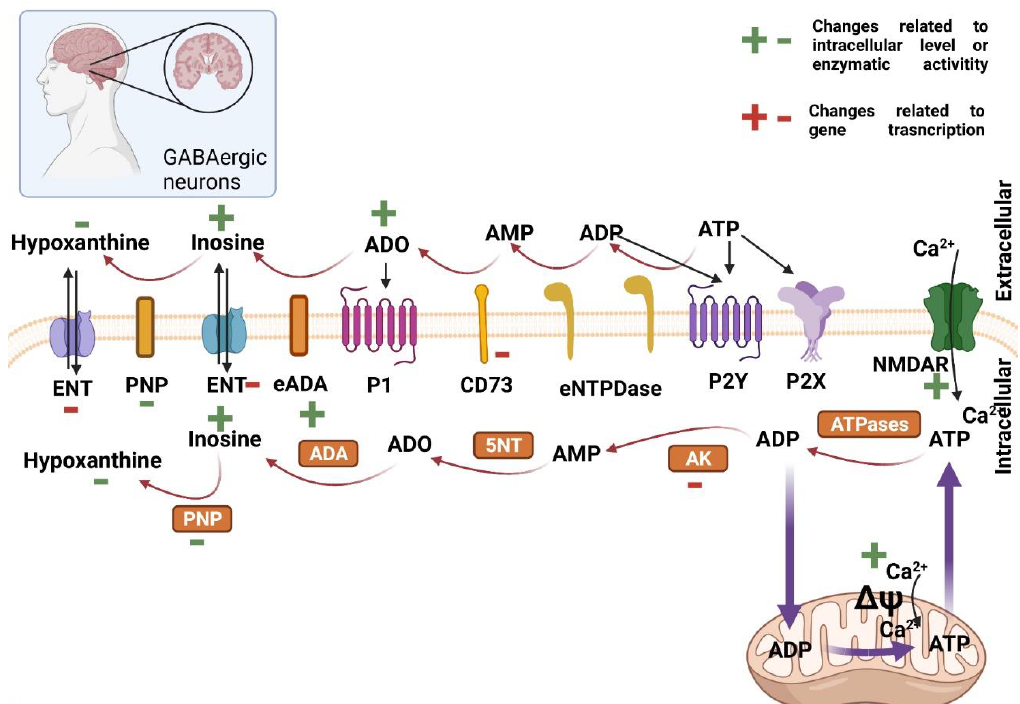
Figure 1. Purine metabolism and signaling in healthy and Huntington’s disease striatal GABAergic neurons. In the neurons of the striatum, ATP is heavily produced by mitochondria which also play important role in buffering cytosolic calcium signaling. In the cytosol, many enzymes (orange boxes) can convert ATP to AMP, ADO, IMP, inosine, and hypoxanthine. The latter ones can be transported to the extracellular milieu by ENT. Extracellularly, ATP can also be converted to inosine and hypoxanthine through a similar cascade by extracellular-faced enzymes anchored to the cell membrane. CD73 is the only extracellular 5NT. Pathophysiology of Huntington’s disease exerts alterations in the activity of enzymes (marked in green +/-) or by genomic expression (marked in red +/-). In Huntington’s disease condition, NMDA-glutamate receptors permit uncontrolled Ca 2+ influx into cells. The excessive Ca 2+ is transported to mitochondria, where it disrupts the membrane potential, releasing cytochrome c and promoting cell death. P1 —Adenosine receptor; P2X —ATP receptor channel; P2Y —ATP/UTP receptor; ATPases —adenosine-5′-triphosphatases; AK —adenylate kinase; eNTPD —ecto-nucleoside triphosphate diphosphohydrolase; 5NT —5′ nucleotidase; CD73 —ecto-5′ nucleotidase; eADA —ecto-adenosine de-